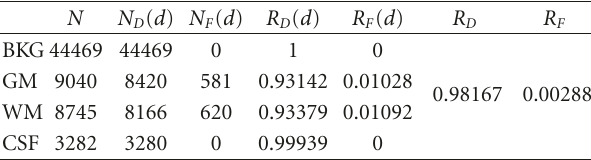
Table 6: Assessment results of FCM (5dB)